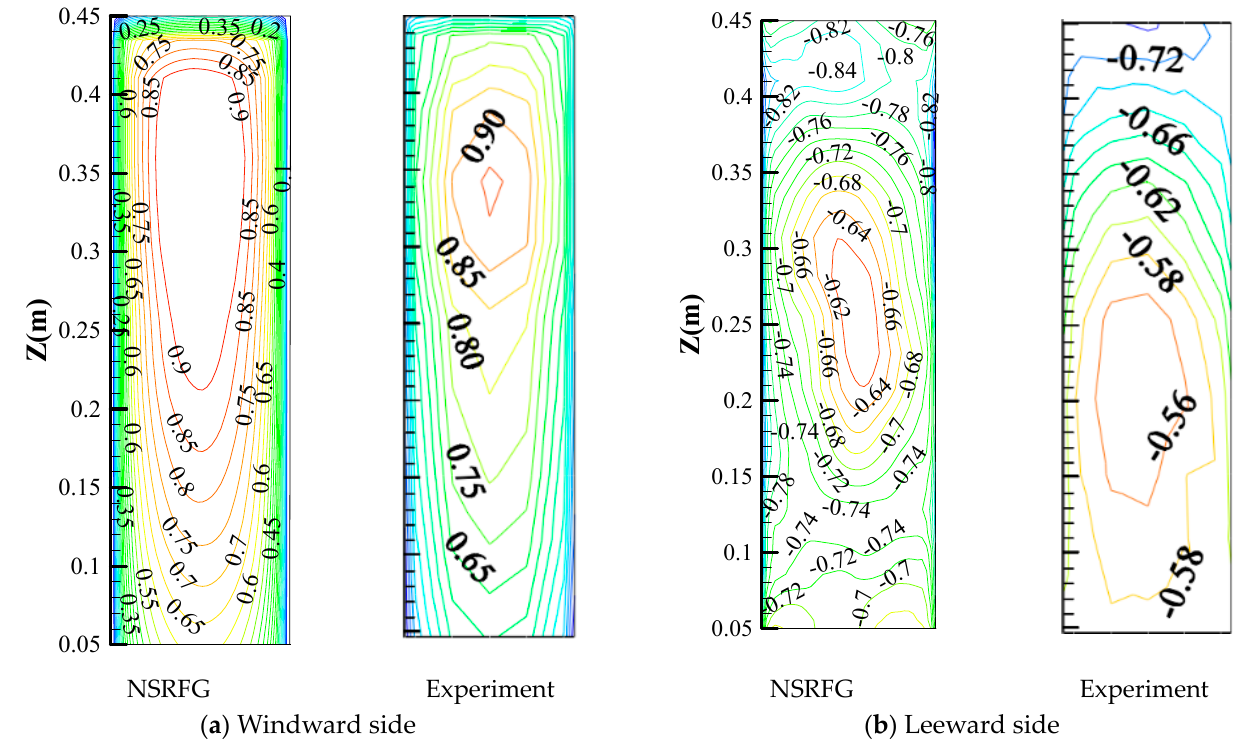
Figure 16. Contours of the mean wind pressure coefficients on the windward and leeward sides.